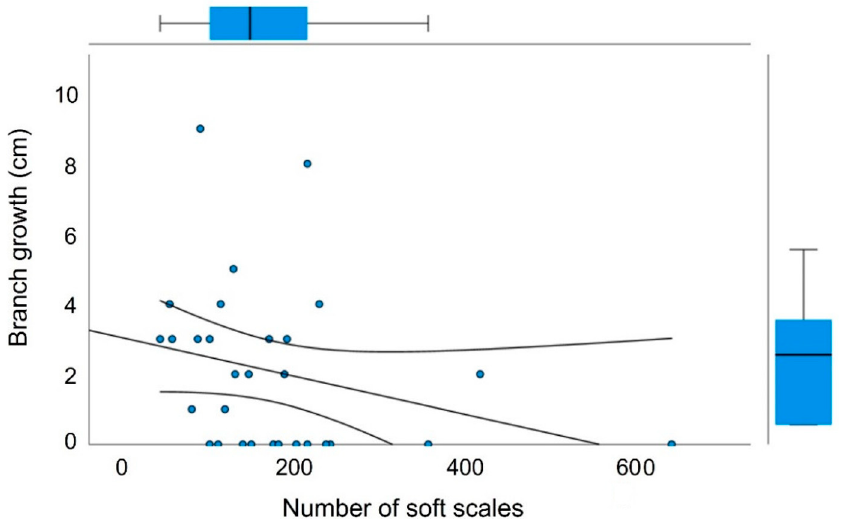
Figure 1. Relationship between the number of herbivores ( Toumeyella martinezae ) and branch growth, showing a decreasing trend. Boxplots along the axes’ margins show the dispersion of variable data; the trend line and corresponding 95% confidence bands are also shown.